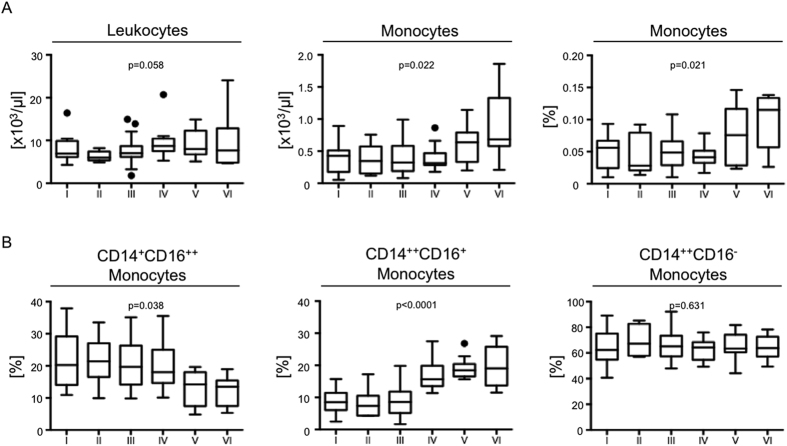
Leukocytes, monocytes and monocyte subsets in PAOD patients.Total leukocyte and monocyte counts, as well as monocyte frequencies among leukocytes (Panel A) as well as monocyte subset distributions among total monocytes (B) were assessed in n = 143 patients with various degrees of PAOD, as represented by different Rutherford stages (I–VI). Relationships between Rutherford stage and the different cell measures were assessed using Pearson’s correlation. A significant correlation is indicated by a p-value < 0.05. Data are presented as box plots, outliers are shown as single dots. Sample sizes are: Rutherford stage I: n = 24, II: n = 8, III: n = 74, IV: n = 16, V: n = 13, VI: n = 8.